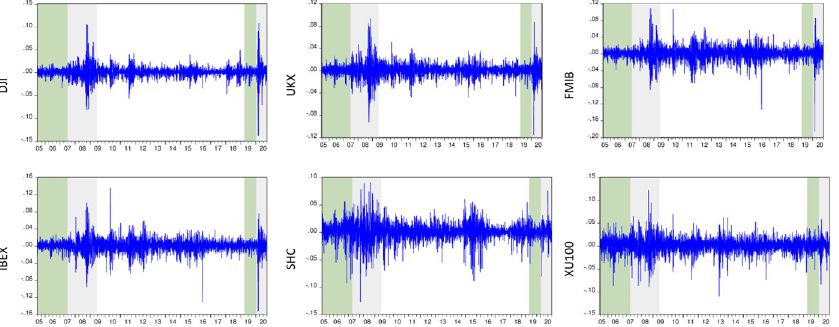
Fig 1. Return series of stock indexes. Green and gray areas demonstrate the pre-crisis and crisis periods, respectively.